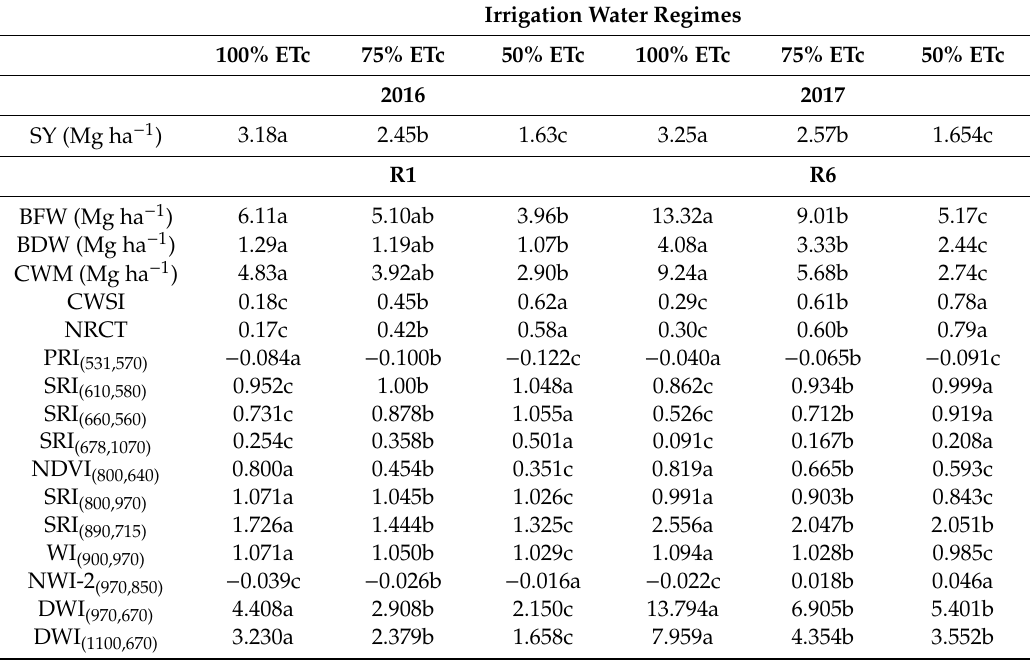
Table 3. Comparison of the mean values of vegetative growth traits (biomass fresh weight (BFW), biomass dry weight (BDW), and canopy water mass (CWM), seed yield (SY)), thermal canopy temperature-based criteria (crop water stress index (CWSI) and normalized relative canopy temperature (NRCT)), and eleven spectral reflectance indices among the three irrigation regimes at the beginning bloom (R1) and full seed (R6) growth